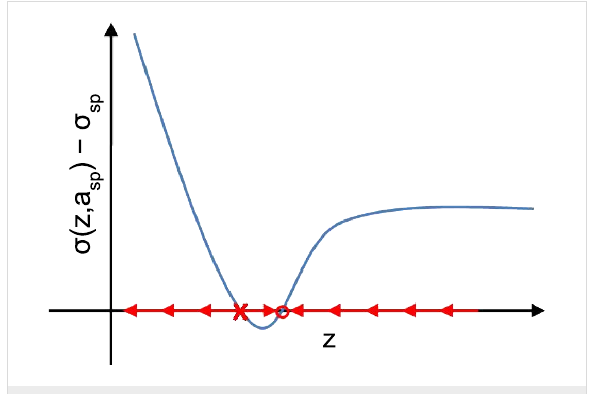
Figure 3: Stability of the z control in FM in vacuum. Arrows indicate the direction of the motion of z when placed under feedback control according to dz / d τ = − K 6 [ σ ( z , a sp ) − σ sp ], where K 6 > 0.